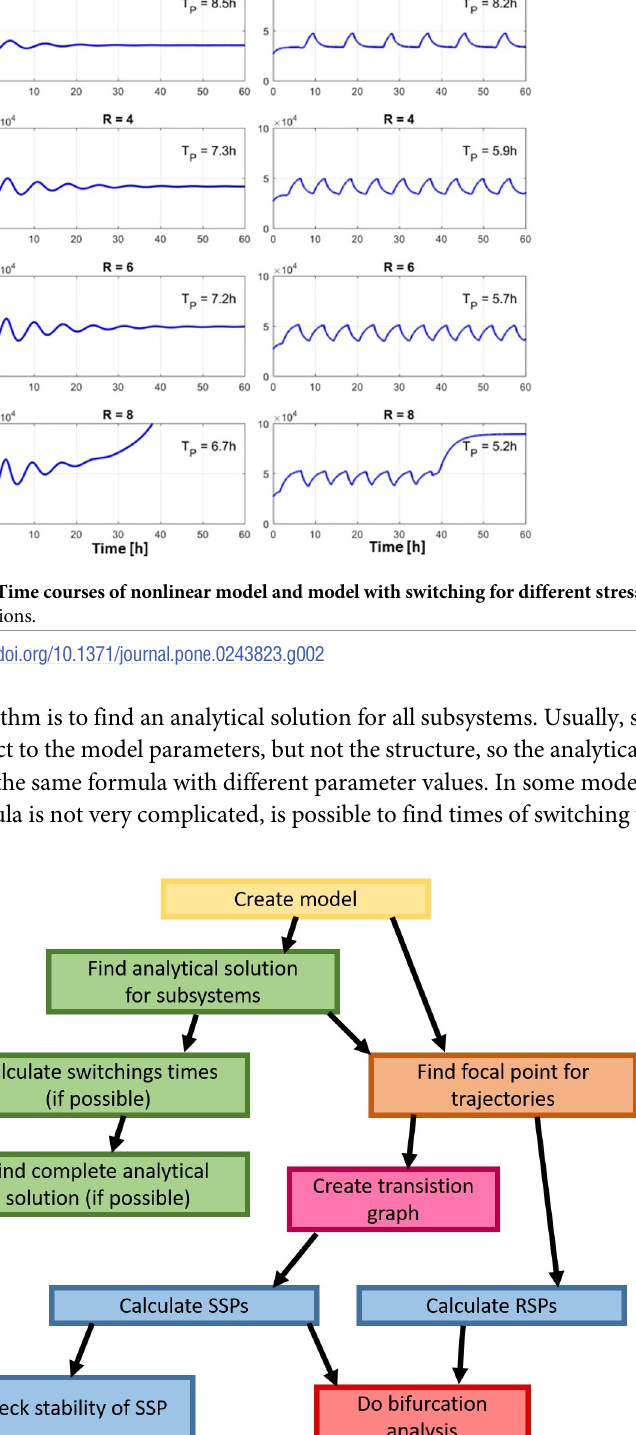
Fig 3. Scheme of the proposed, complex analysis of the systems with